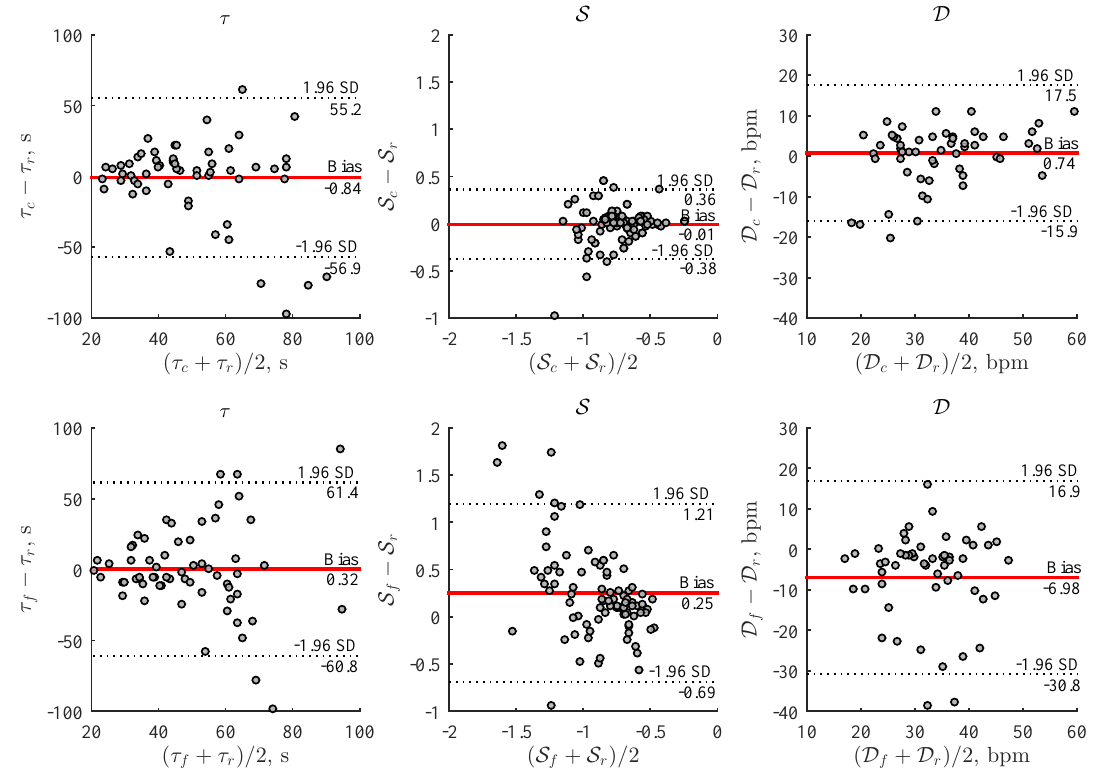
Figure 5. Comparison of HRR parameters estimated using the wrist-worn device and smart wristband with respect to the reference ECG at a stair climbing rate of 96 steps/min (data of all three repeated stair climbing activities were